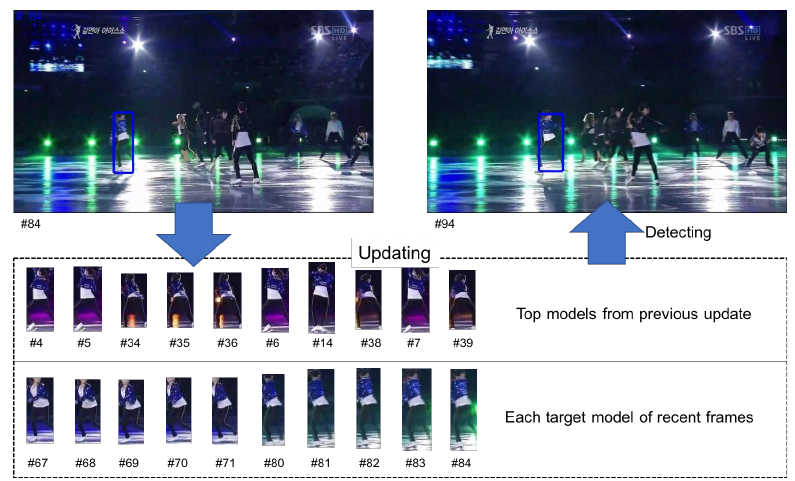
Figure 4. Target models in F at the update time and the detection of the target at a later frame.